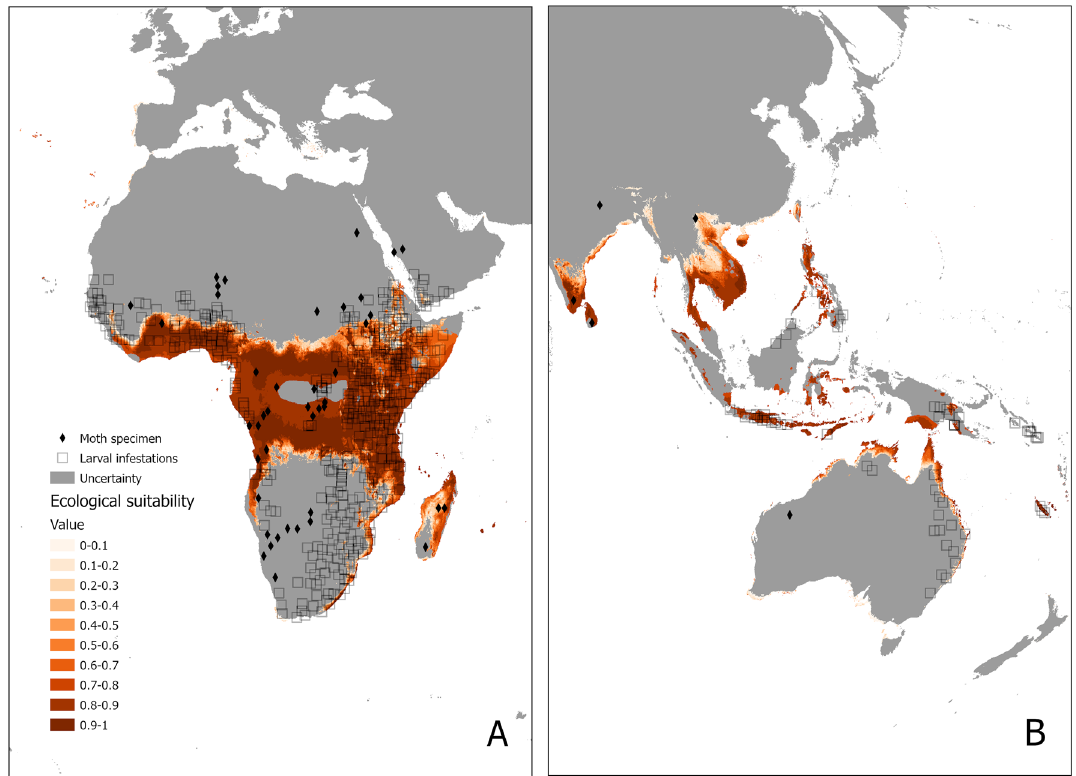
Figure 5. Recorded worldwide S. exempta larval infestations and moth specimens (reproduced with permission after Ref. 21 ) overlapping Fig. 4 environmental suitability model. The map was generated in R v.4.0.2 104 (https:// www.r- proje ct. org/) using RStudio v.1.3.1093 (https:// www. rstud io.